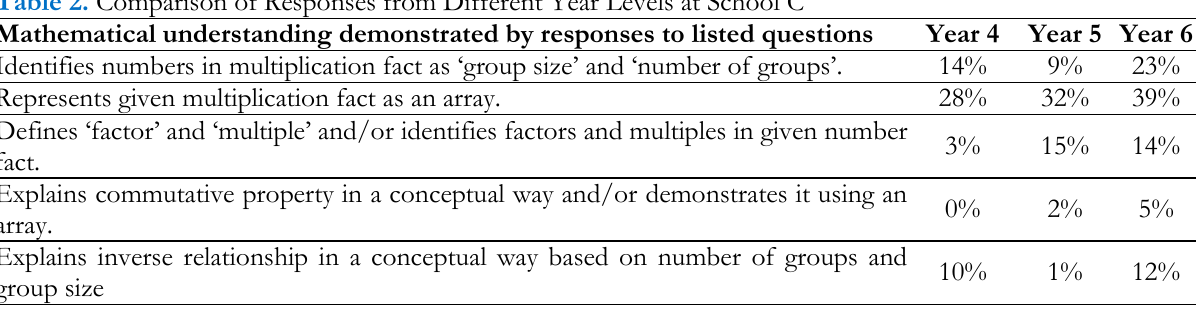
Table 3. Comparison within Year Levels in School C Mathematical understanding demonstrated by responses to listed